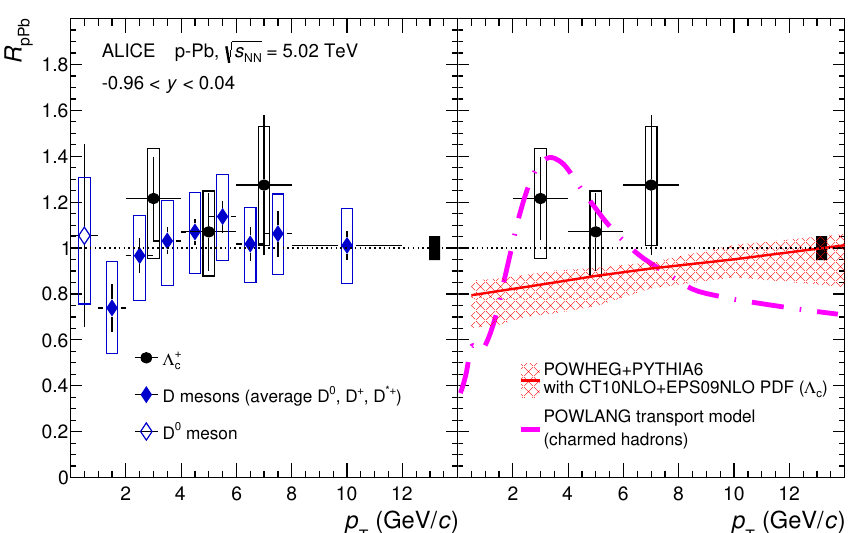
p baryons in p-Pb collisions at s NN c R pPb from the powheg c